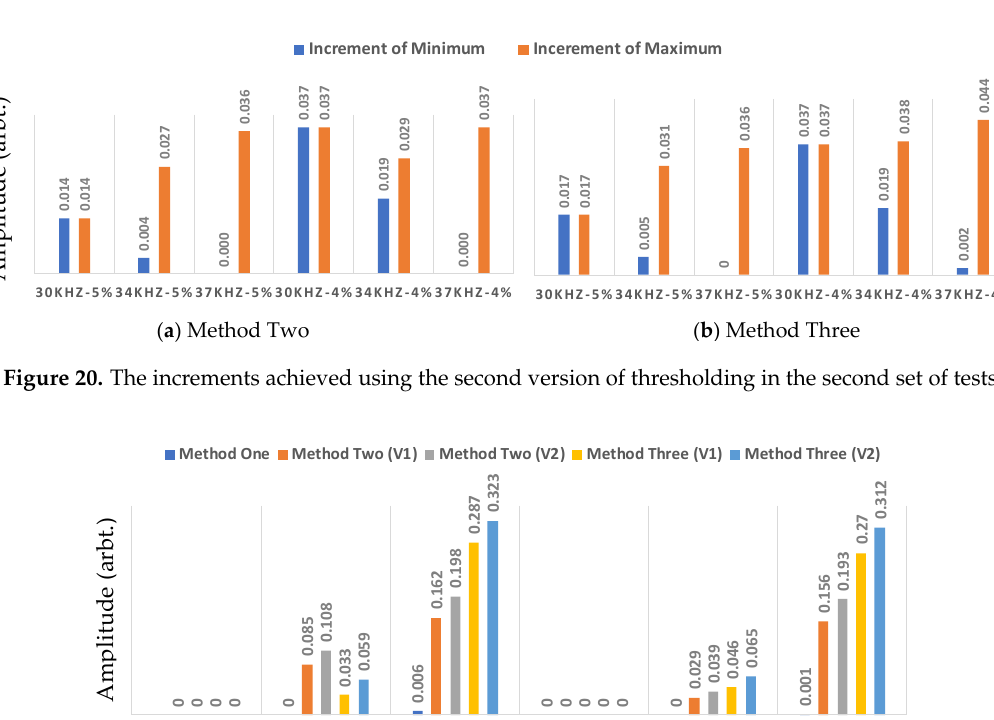
Figure 19. Limits achieved using method three on the second set of tests.